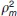
Disclosing of an isotropic TRPV1 component by iMSD analysis on cell transfected with TRPV1-YFP alone.(a) TIRF microscopy image of a CHO cell expressing TRPV1-YFP. (b) Temporal evolution of the correlation function with the corresponding Gaussian fit and residues. The fitting is a sum of two components that account for binding and superdiffusion regimes. The residuals at short timescale are non-zero and they can be attributed to diffusion of TRPV1 molecule not directly involved in tubulin or caveolin interactions. (c) Average normalized correlation functions of TRPV1 for distances between about 500 nm e 1 μm. The data are smoothed. The position of the maximum of the curves moves at increasing of distance along the time. The shift in the maximum indicates spatial spreading of observed molecules. (d) Plot of position of each maximum identified by ρm2 and τm. The linear trend (R2 = 0.998) indicates free diffusion at this spatial scale of the TRPV1-I pool.